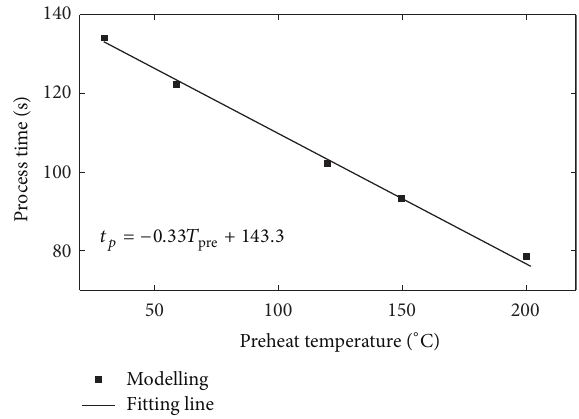
Figure 6: Effect of the preheating temperature on the process